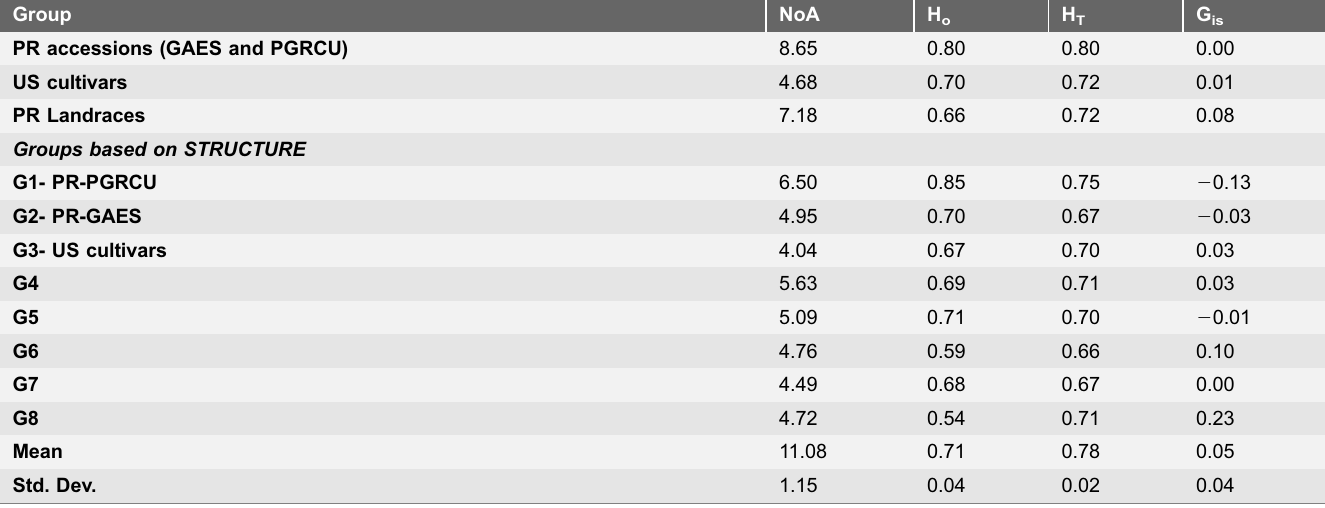
Table 2. Summary statistics of genetic diversity estimators at 23 SSR loci for 167 sweet potato